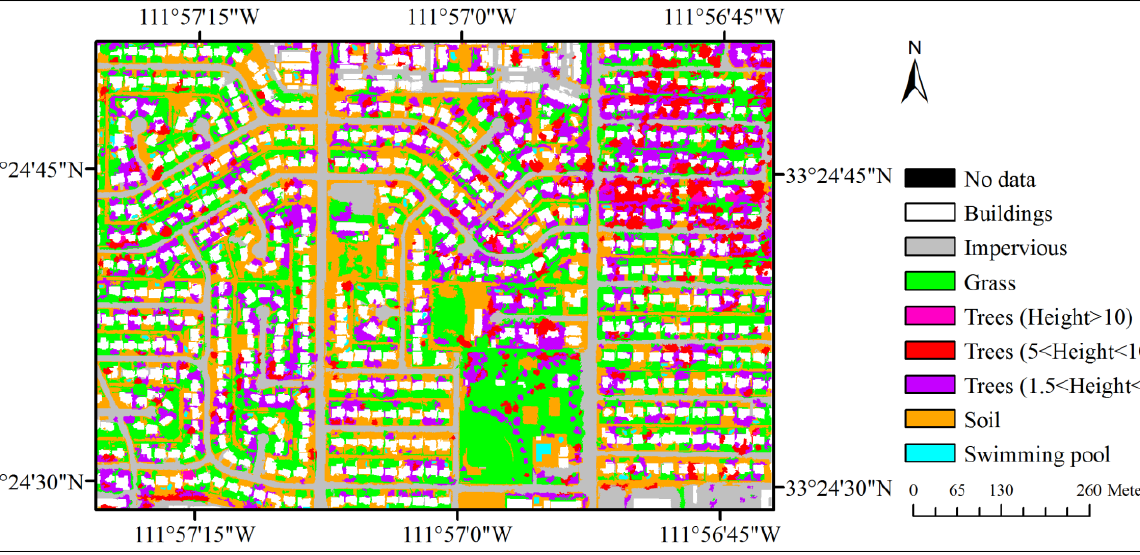
Figure 9. Land use/land cover map from QuickBird